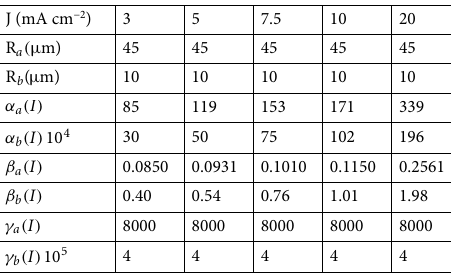
Table 3. Modelling parameters for the carbon